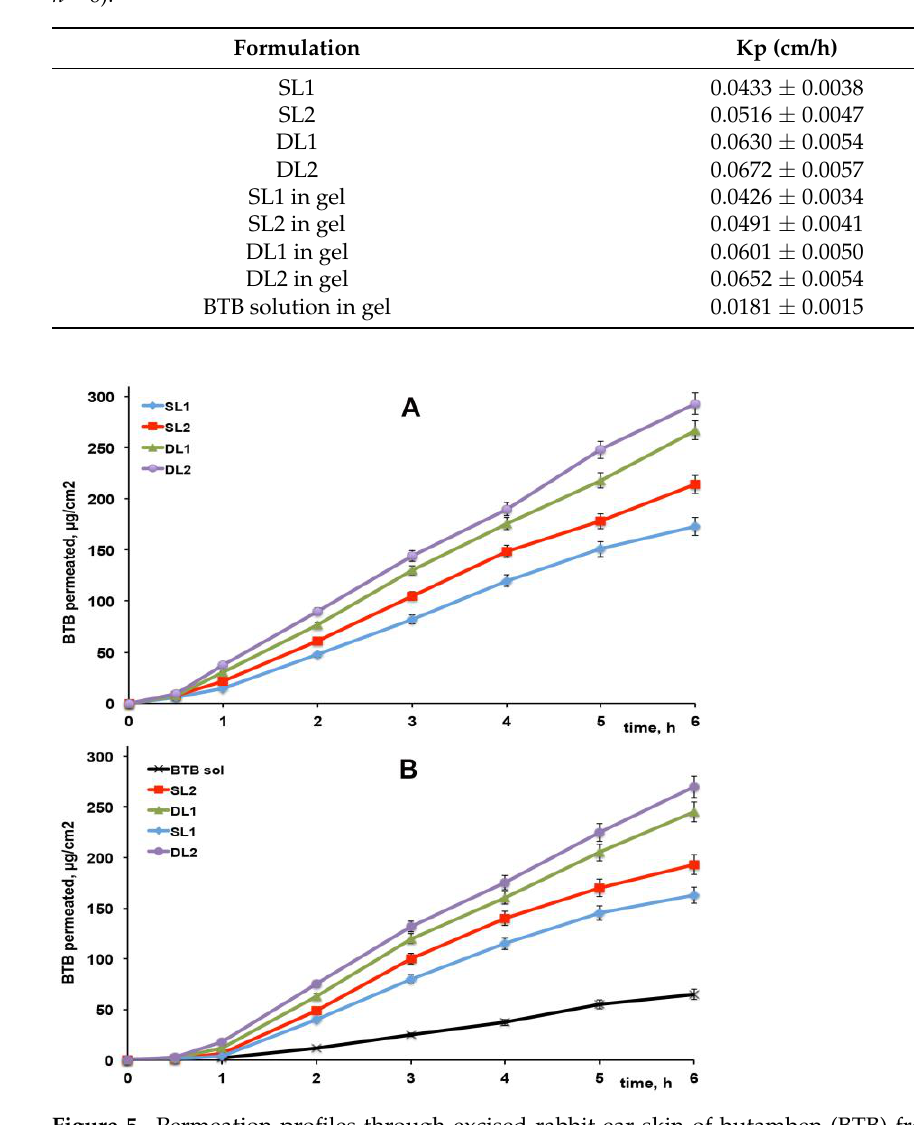
Figure 5. Permeation profiles through excised rabbit ear skin of butamben (BTB) from 1% w / v drug-loaded liposomal dispersions as such ( A ) or dispersed (50:50 w / w ) in an aqueous Carbopol gel ( B ) (see Table 3 for liposomal formulations composition).